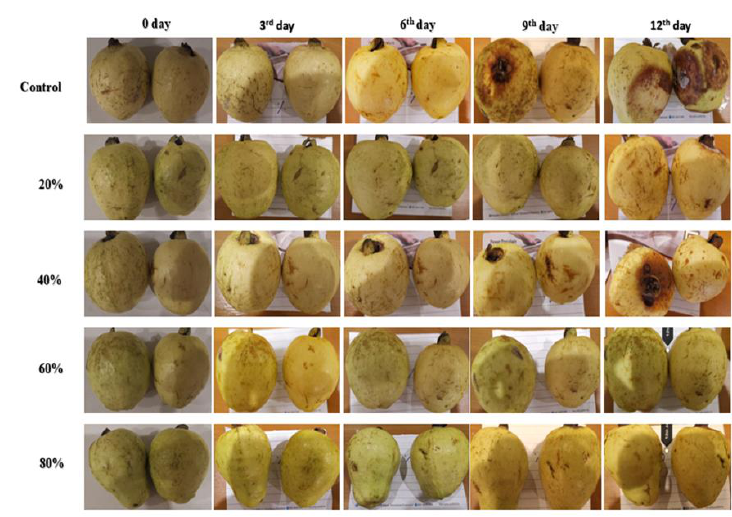
Figure 1. Effect of aloe vera (AV) gel coating on the storage life of guava fruits from the start until the end of the analysis on the 12th day.